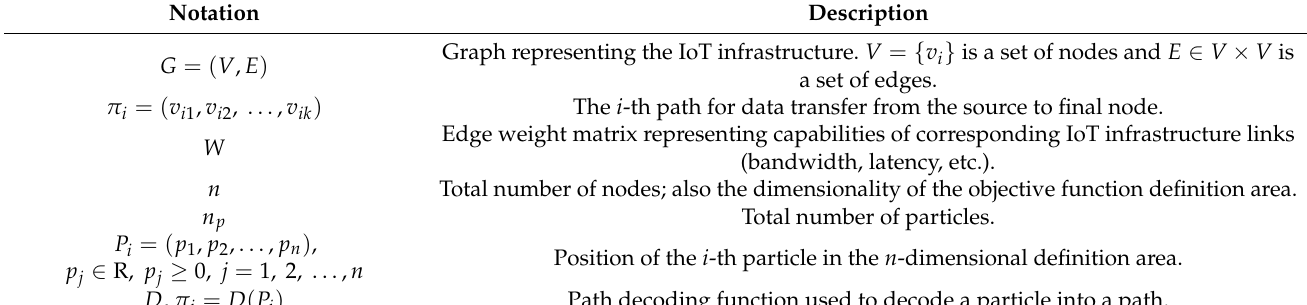
Table 1. The key notations used in this paper.